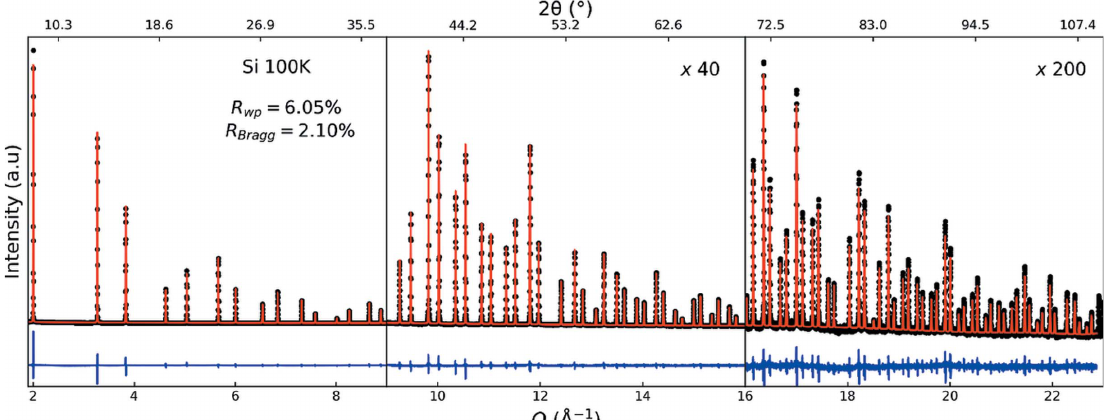
Figure 1 Rietveld analysis results of the total-scattering data of Si at 100 K obtained using OHGI. Black dots, red lines and blue lines show the data points, the calculated pattern and the difference,